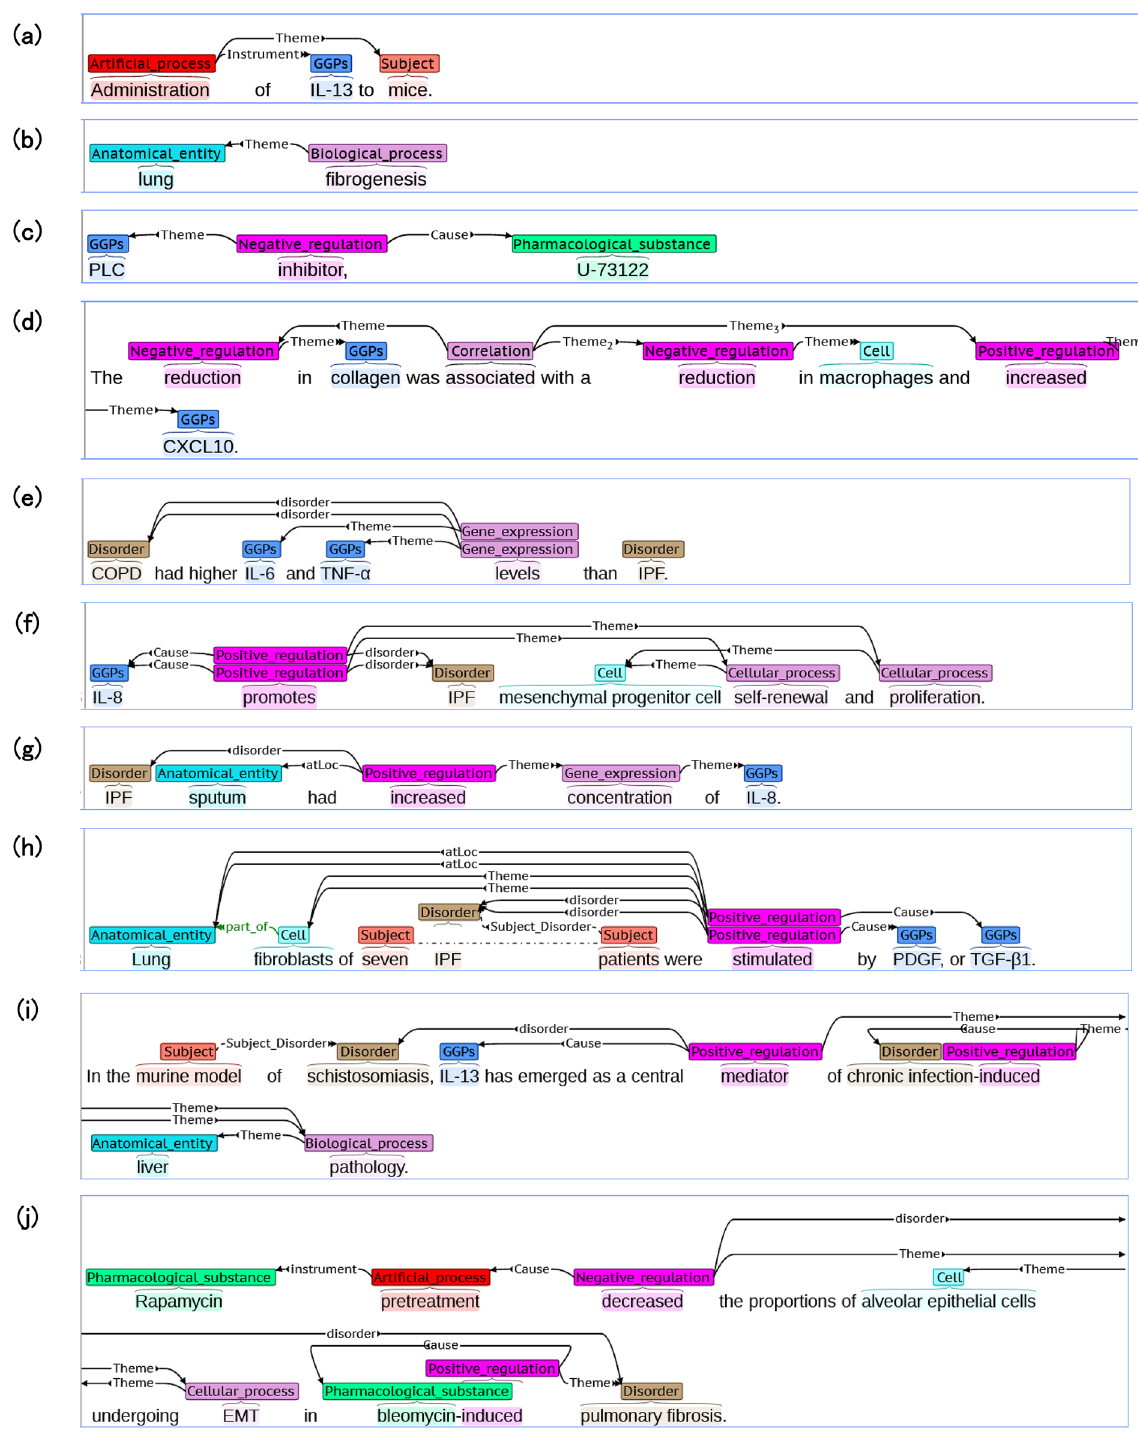
Figure 1. Annotation examples shown in format of brat rapid annotation tool. “Artificial_process” event ( a ), “Biological_process” event ( b ), “Negative_regulation” event ( c ), “Correlation” event with two “Negative_ regulation” events and “Positive_regulation” event ( d ), ‘ disorder ’-related “Gene_expression” events ( e ), ‘ disorder ’- related “Positive_regulation” events with “Cellular_process” events ( f ), ‘ disorder ’-related “Positive_regulation” event with “Gene_expression” event ( g ), ‘ disorder ’-related “Positive_regulation” events ( h ), ‘ disorder ’-related “Positive_regulation” events with “Biological_process” event ( i ) and ‘ disorder ’-related “Negative_regulation” event with “Artificial_process” event, “Cellular_process” event and “Positive_regulation” event ( j